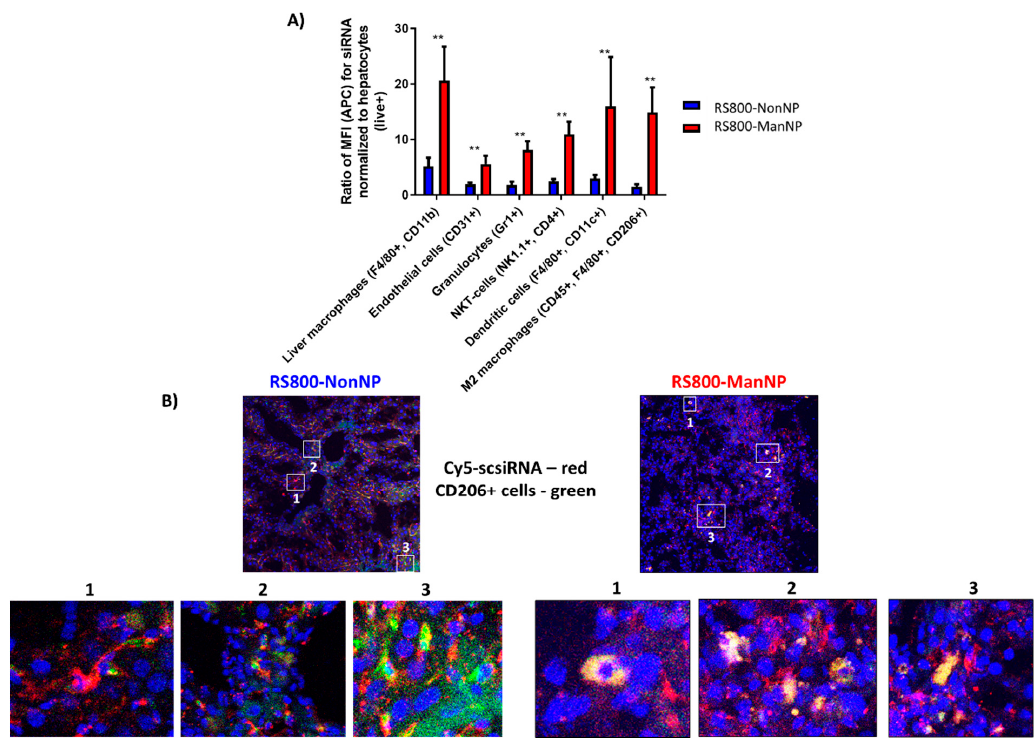
Figure 4. In vivo uptake of Cy5-scsiRNA-loaded RS800-(Non-)ManNP on cellular level. Fibrotic livers were harvested 12 h after a single IV injection of Cy5-scsiRNA-loaded RS800-(Non-)ManNP (2 mg/kg siRNA). ( A ) In vivo cellular uptake of both carriers (RS800-NonNP and -ManNP) in (non-)parenchymal liver cells as assessed by FACS analysis of single cell suspensions obtained from harvested livers. Cell-specific uptake in relation to hepatocytes as most abundant liver cells was significantly enhanced for RS800-ManNP in M2 polarized macrophages (CD45 + , F4/80 + and CD206 + ) after normalization to hepatocyte uptake (** p < 0.001). ( B ) Confocal fluorescence laser microscopy of liver cryosections obtained from fibrotic mice. Liver sections were stained for the mannose receptor CD206 (green) and Cy5-siRNA (red). Colocalization of carriers with CD206+ cells is indicated by yellowish staining. Sections of fibrotic mice injected with PBS as vehicle control served to normalize for background fluorescence (Figure S4).